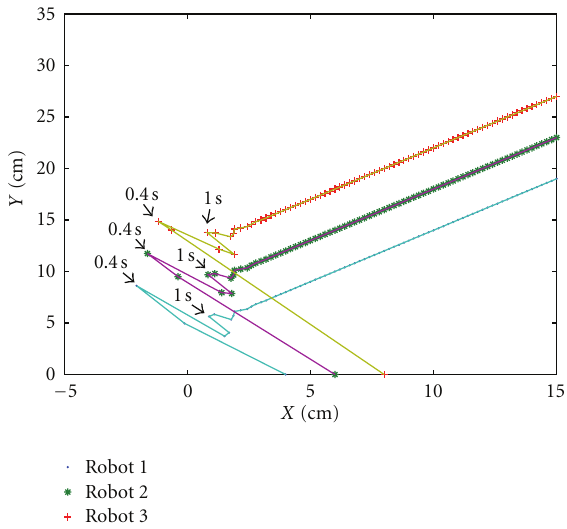
Figure 4: Evolution of the robot group movement with long-time communication delay ( τ = 1